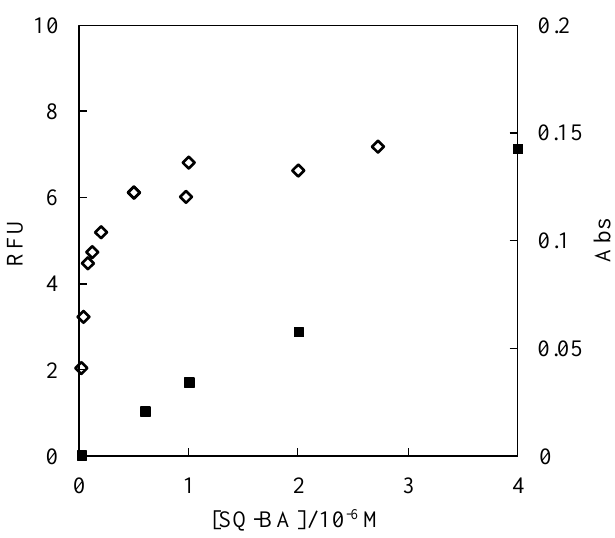
Figure 2. Effect of the dye concentration on fluorescence intensity (  ) and absorbance (■) in aqueous carbonate (10 mM, pH 10.0) buffer solution.  [SQ-BA] = 1.0 × 10 −8 –4 × 10 −6